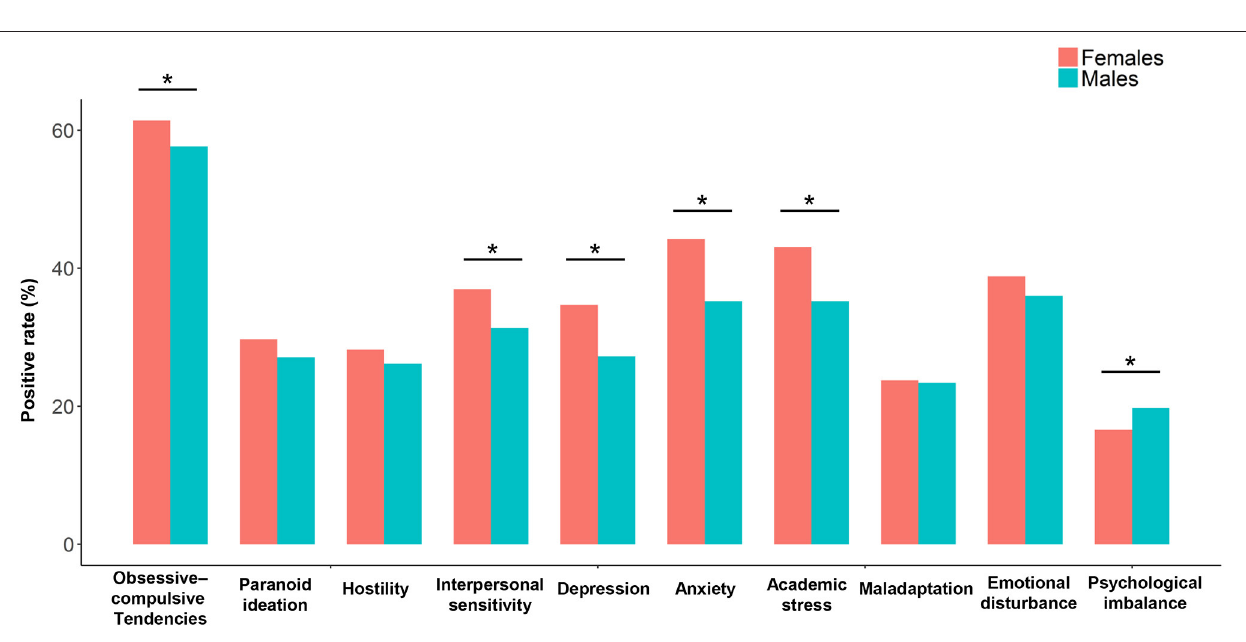
FIGURE 2 | Comparisons on positive rates of each mental health problem between the female and male participants. The “*” indicates a significant sex difference with p <